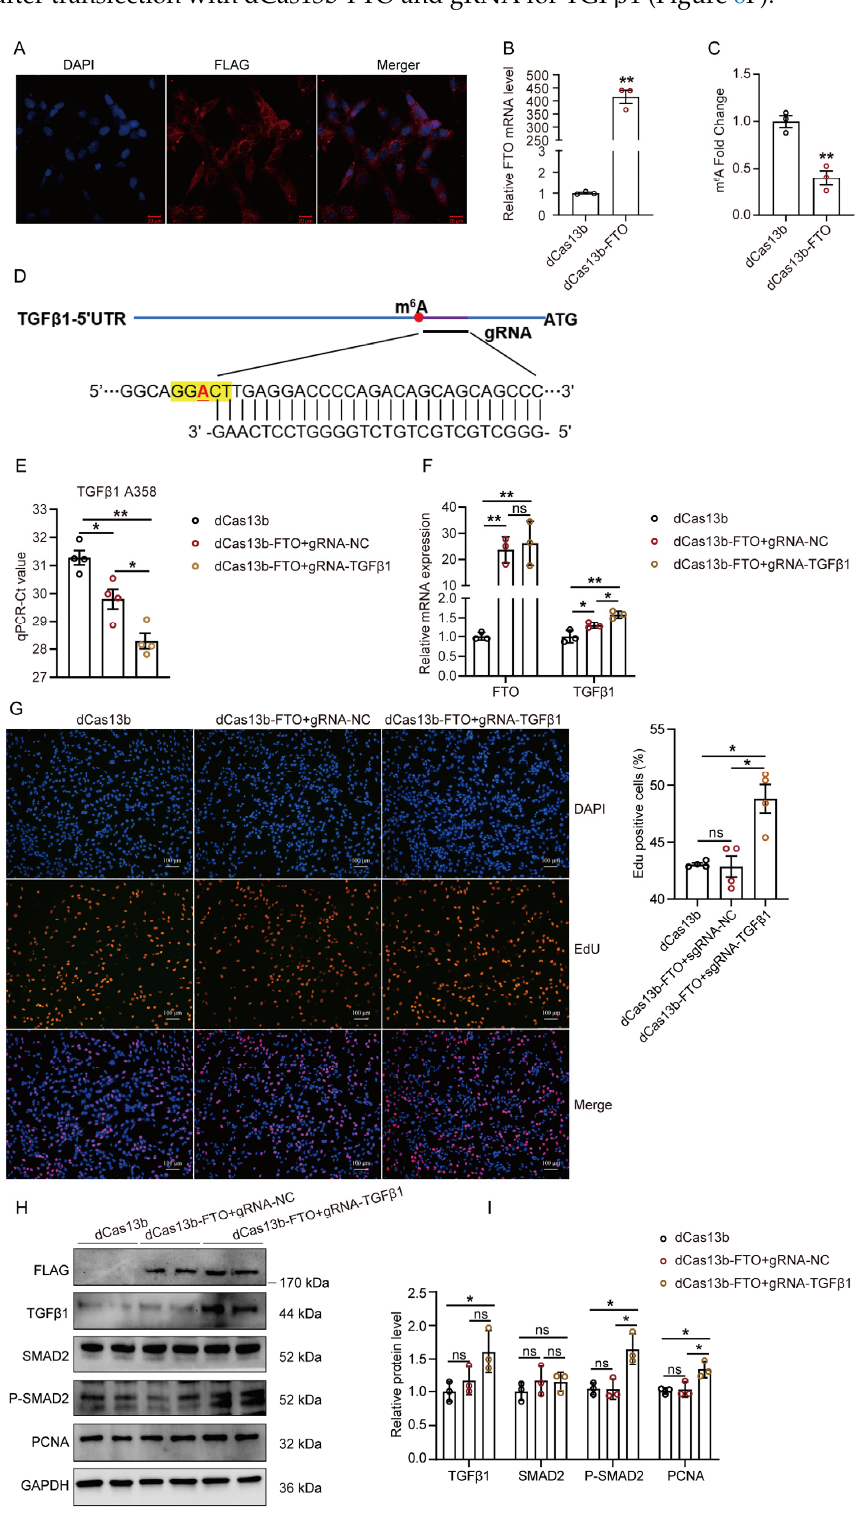
Figure 6. CRIPSR/dCas13b-FTO increased the expression level of TGF β 1 and promoted GPMs proliferation. After transfection with dCas13b-FTO-FLAG construct for 48 h: ( A ) Subcellular